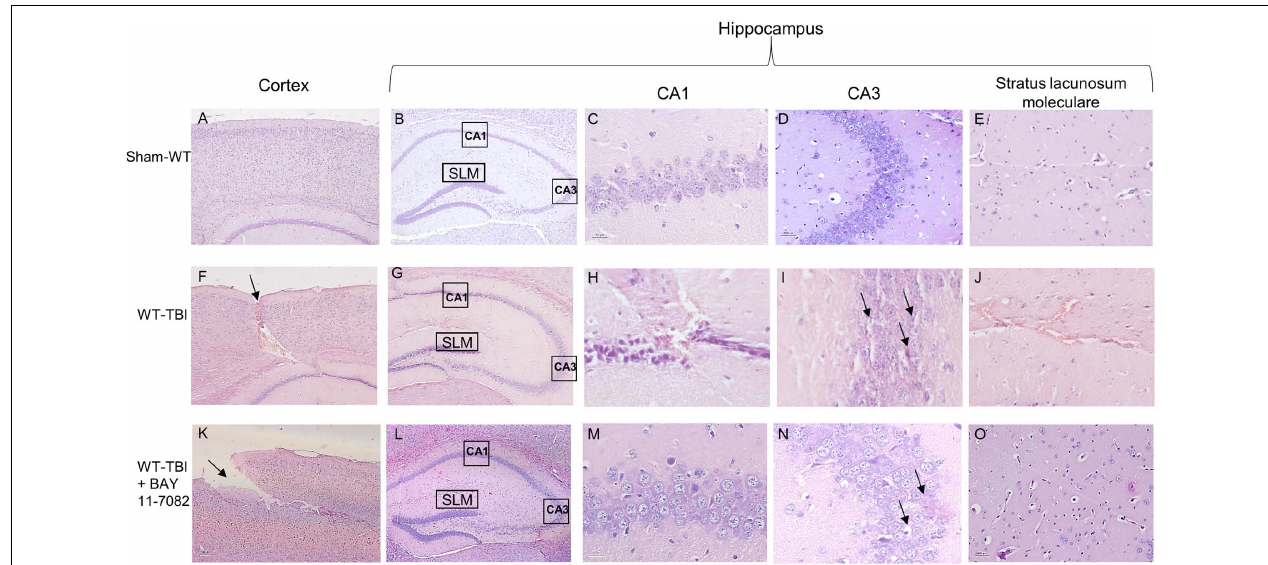
FIGURE 3 | Representative H&E staining of brain tissue from WT animals 24 h following TBI. (A) cortex of Sham-WT animal. Original magnification X5. (B) hippocampus of Sham-WT animal. The rectangle indicates the Ca1, Ca3, and stratus lacunosum moleculare areas used for enlargement. Original magnification X5. (C) Ca1 area of Sham-WT animal. Original magnification X40. (D) Ca3 area of Sham-WT animal. Original magnification X40. (E) Stratus lacunosum moleculare of Sham-WT animal. Original magnification X20. (F) cortex of WT-TBI animal, the arrow indicates the impact point, hemorrhage and edema are markedly